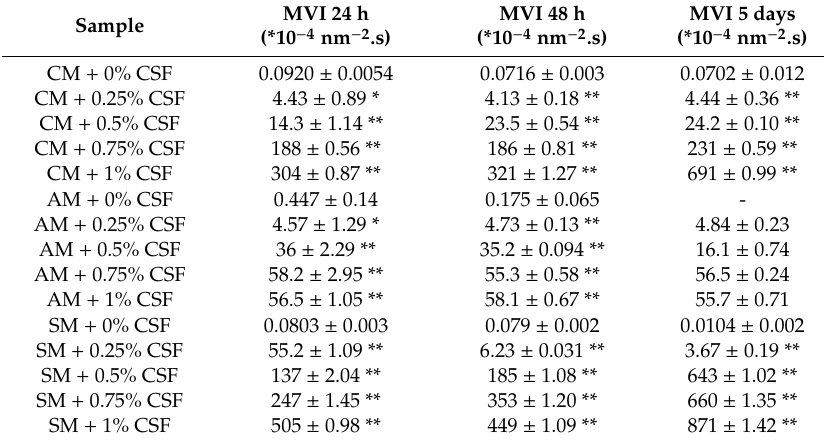
Table 3. MVI (nm − 2 .s) values obtained at the end of fermentation and after 24 h, 48 h and 5 days of storage at 4 ◦ C. The results are the mean of three experiments ± standard deviation. (* p < 0.05; ** p < 0.001 of milk-based yogurt-like structure with respect to the same storage time of samples without CSF).